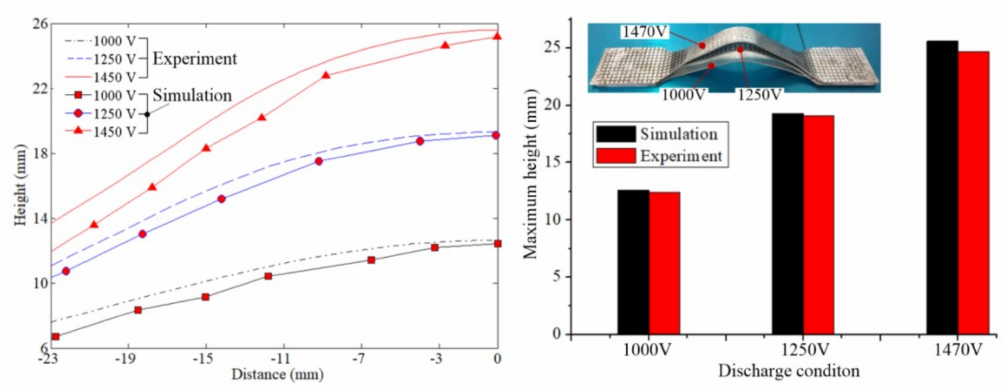
Figure 11. Experimental and simulation results: ( a ) the final profiles on path 2 and ( b ) the maximum height of the sample